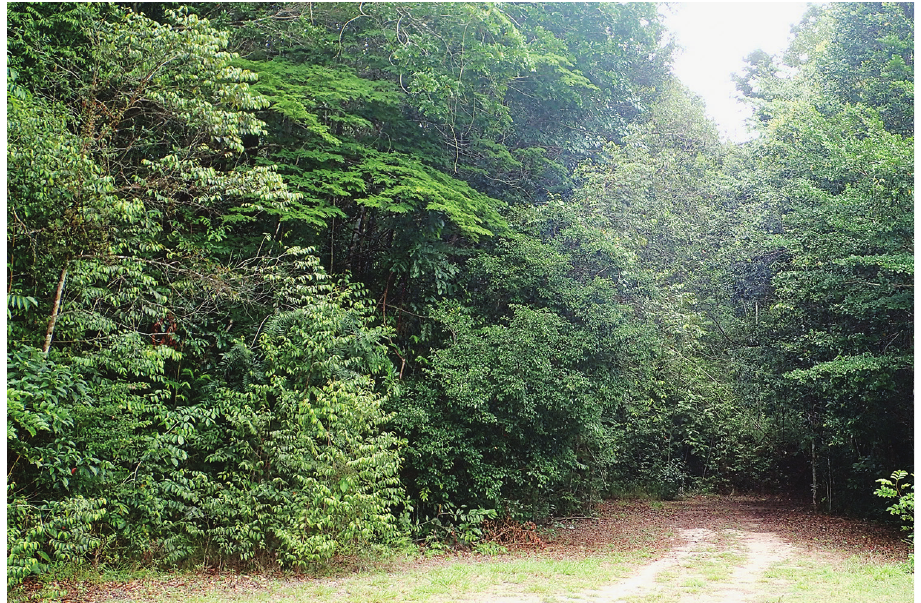
Figure 36. Coastal dry forest habitat (Mana, French Guiana). Photograph J.